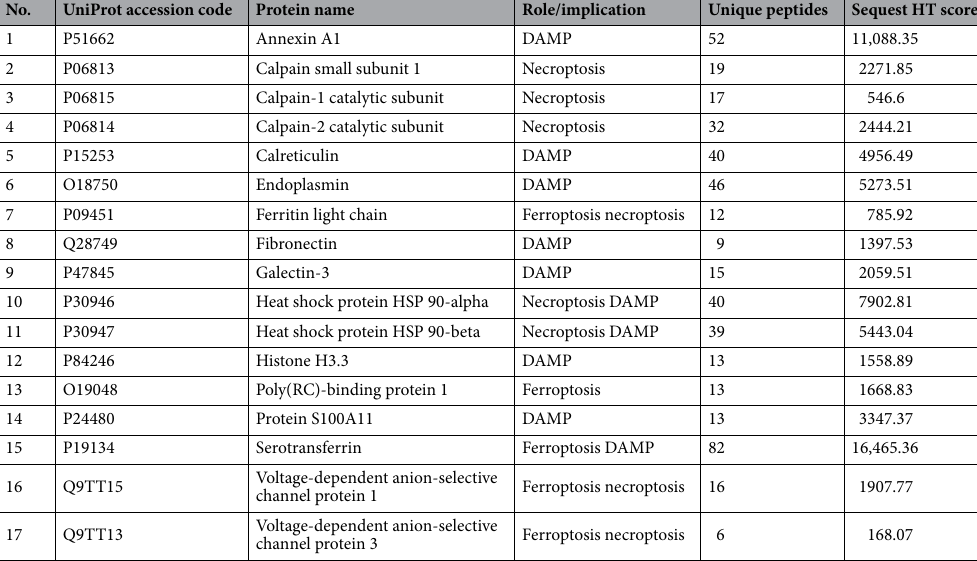
Table 1. The list of differentially abundant proteins in the ascending aorta samples from all experimental animals using label-free relative mass spectrometric analysis involved in ferroptosis, necroptosis and associated DAMPs with altered mass spectrometric abundance > 1.5-fold ( p < 0.05) due to the hyperlipidemic diet administration with or without lipid-lowering treatment. The control group (C), early atherosclerotic group (Ae), atherosclerotic group stabilized by statin and anti-PCSK9 administration (As) and late atherosclerotic group (Al). Parameters of protein inference are also presented (UniProt accession code, name, the number of unique peptides/proteins based on which the protein was identified and Sequest HT protein identification score).